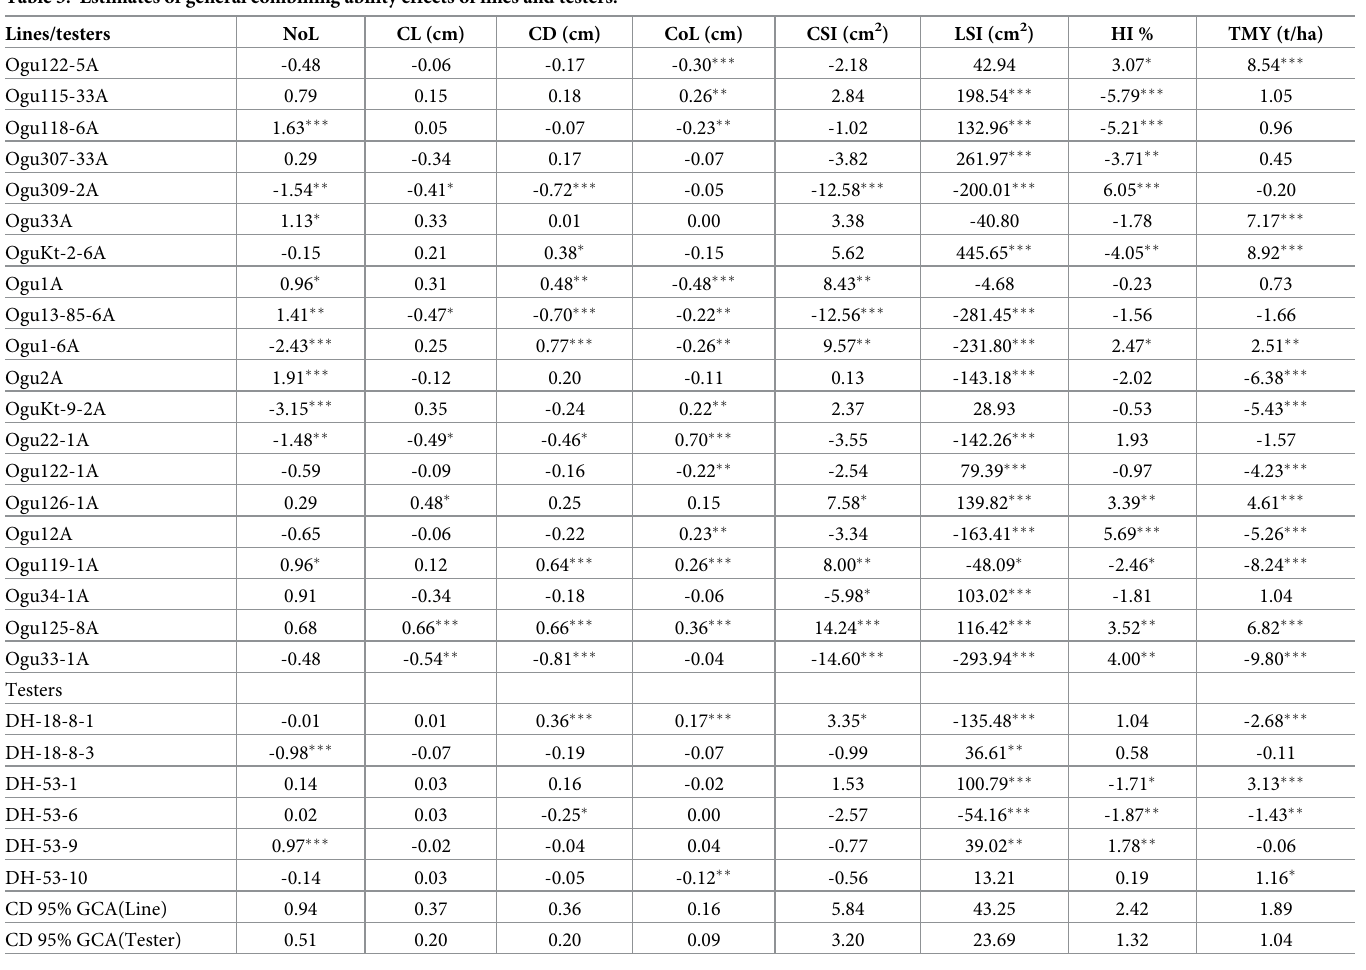
Table 5. Estimates of general combining ability effects of lines and